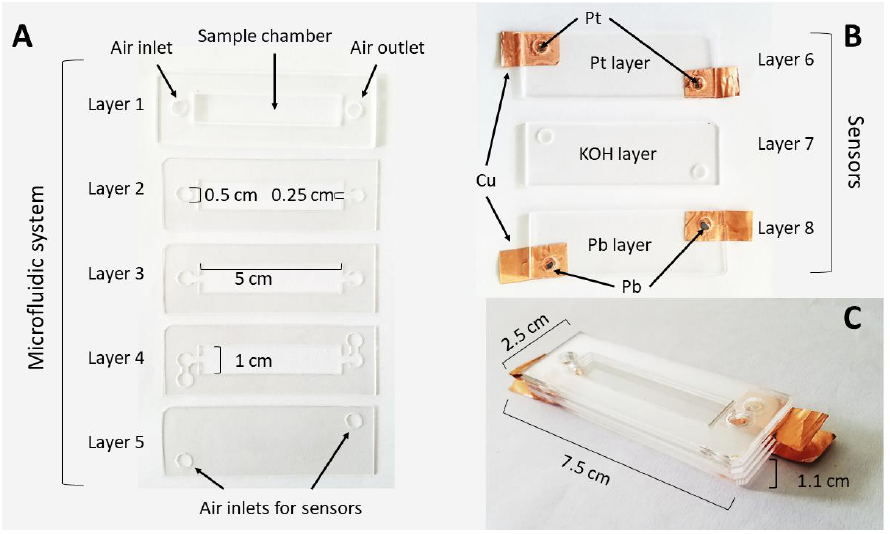
Figure 2. Respirometric microsystem description. ( A ) Microfluidic system; ( B ) oxygen sensors; ( C ) respirometric microsystem.